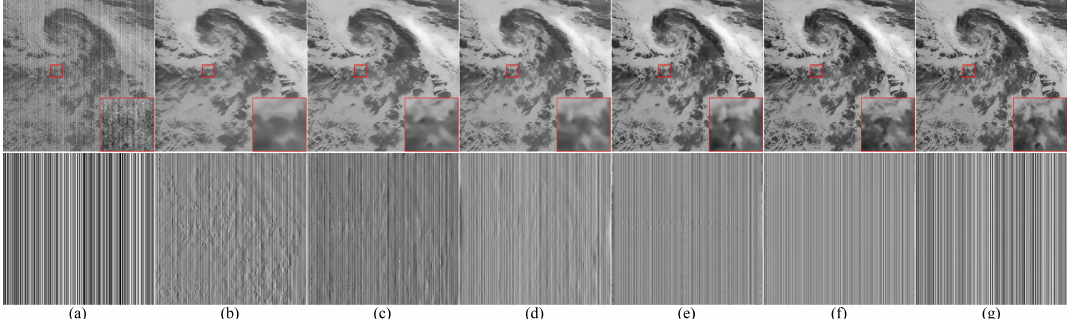
Figure 10. Visual comparisons on the STM1 image in Figure 5a. Where noise level σ = 30, the pro- portion P and the intensity I of the non–periodical stripe are respectively 0.4 and 30. ( a ) Upper: Degraded STM1 image. Down: Ground-truth stripe. ( b – g ) Estimated images and stripes respectively produced by the UTVSR, WNNM-WDSUV, HSI-DeNet, UV-DCNN, JAWS, and proposed methods.